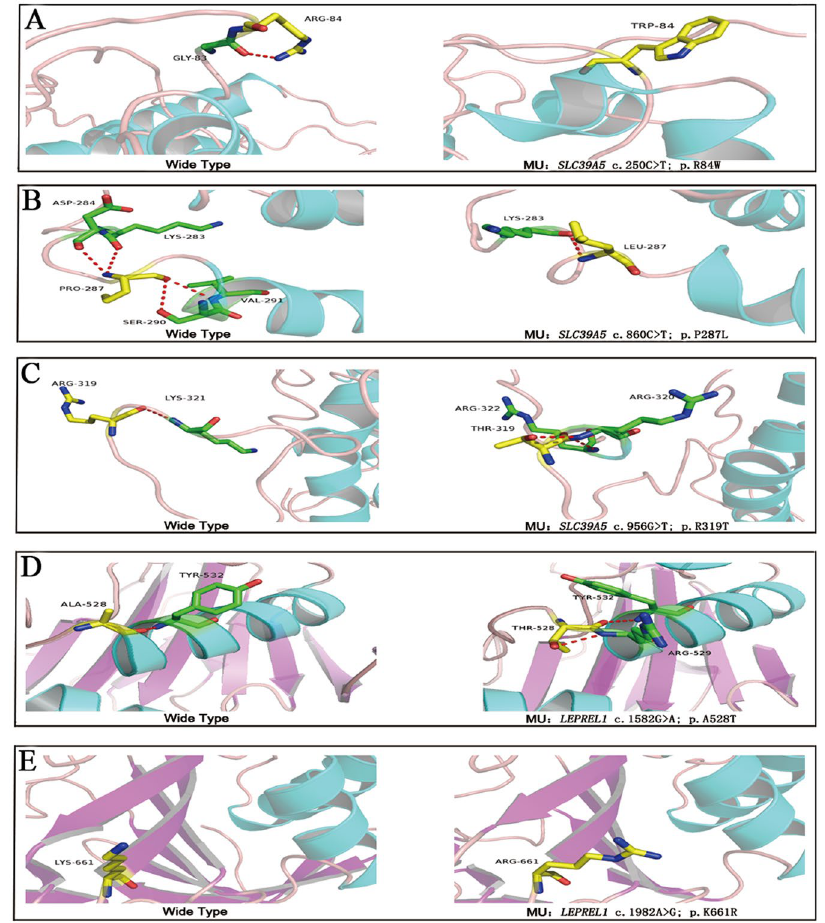
Figure 4. Predicted three-dimensional structure of proteins. Predicted crystal structures of wild type (left) and mutant (right) proteins. Yellow represents residue of wild type (left) and mutant (right), while green indicates residues that interact with wild-type (left) and mutant residue (right) ( A – E